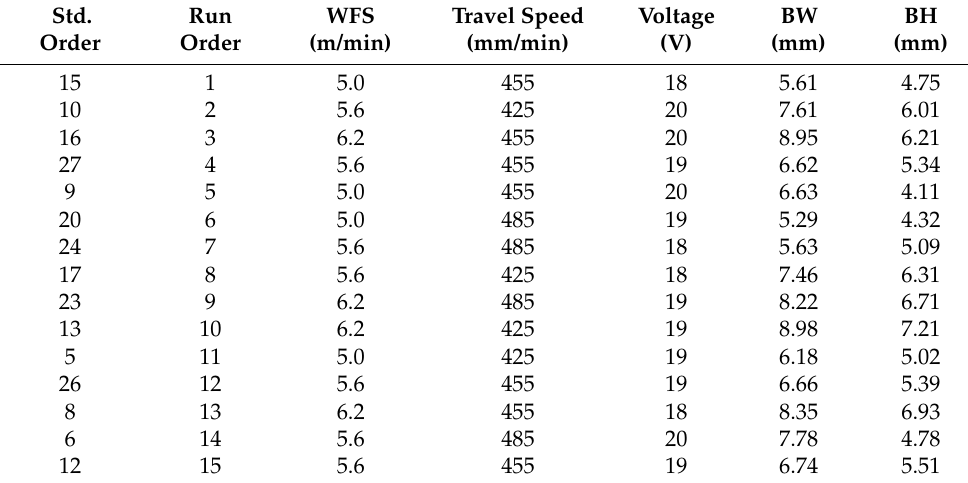
Table 3. RSM BBD design with readings of BW and BH responses.